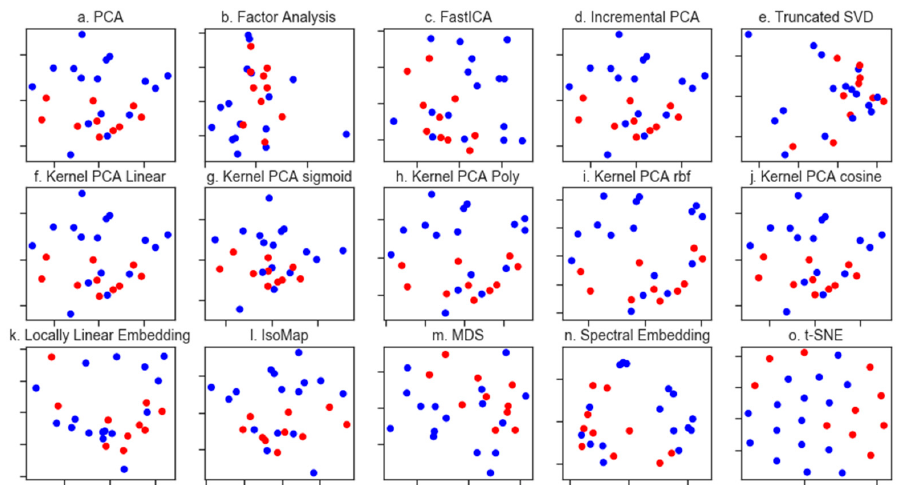
Figure 2. Dimensionality reduction methods applied to the FTIR dataset. Throughout, patients who survived are coloured blue whilst those who did not are coloured red. Matrix decomposition methods: ( a ). PCA ( b ). Factor analysis ( c ). Fast Independent Components Analysis (FastICA) ( d ). Incremental PCA ( e ). Truncated singular value decomposition (SVD) ( f ). Kernel PCA using a linear kernel ( g ). Kernel PCA using a sigmoid kernel ( h ). Kernel PCA using a polynomial kernel ( i ). Kernel PCA using a radial basis function kernel and ( j ). Kernel PCA using a cosine kernel. Manifold learning methods: ( k ). Locally linear embedding ( l ). Isomap m. Multidimensional scaling (MDS) ( m ). Spectral embedding and ( n ). t-distributed stochastic neighbour embedding (t-SNE).